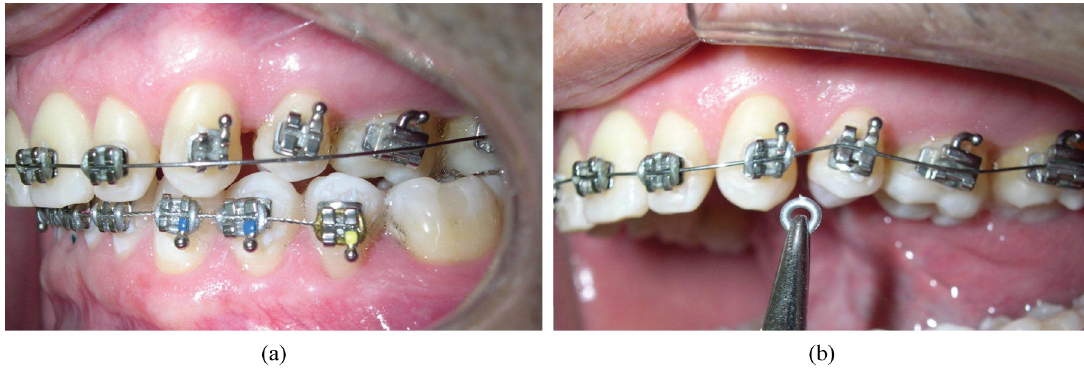
Figure 1. Superelastic NiTi 0.014-inch during initial alignment orthodontic stage, before (left) and after (right) bracket engagement. Note the degree of misalignment that the wire can tolerate due to superelastic properties.